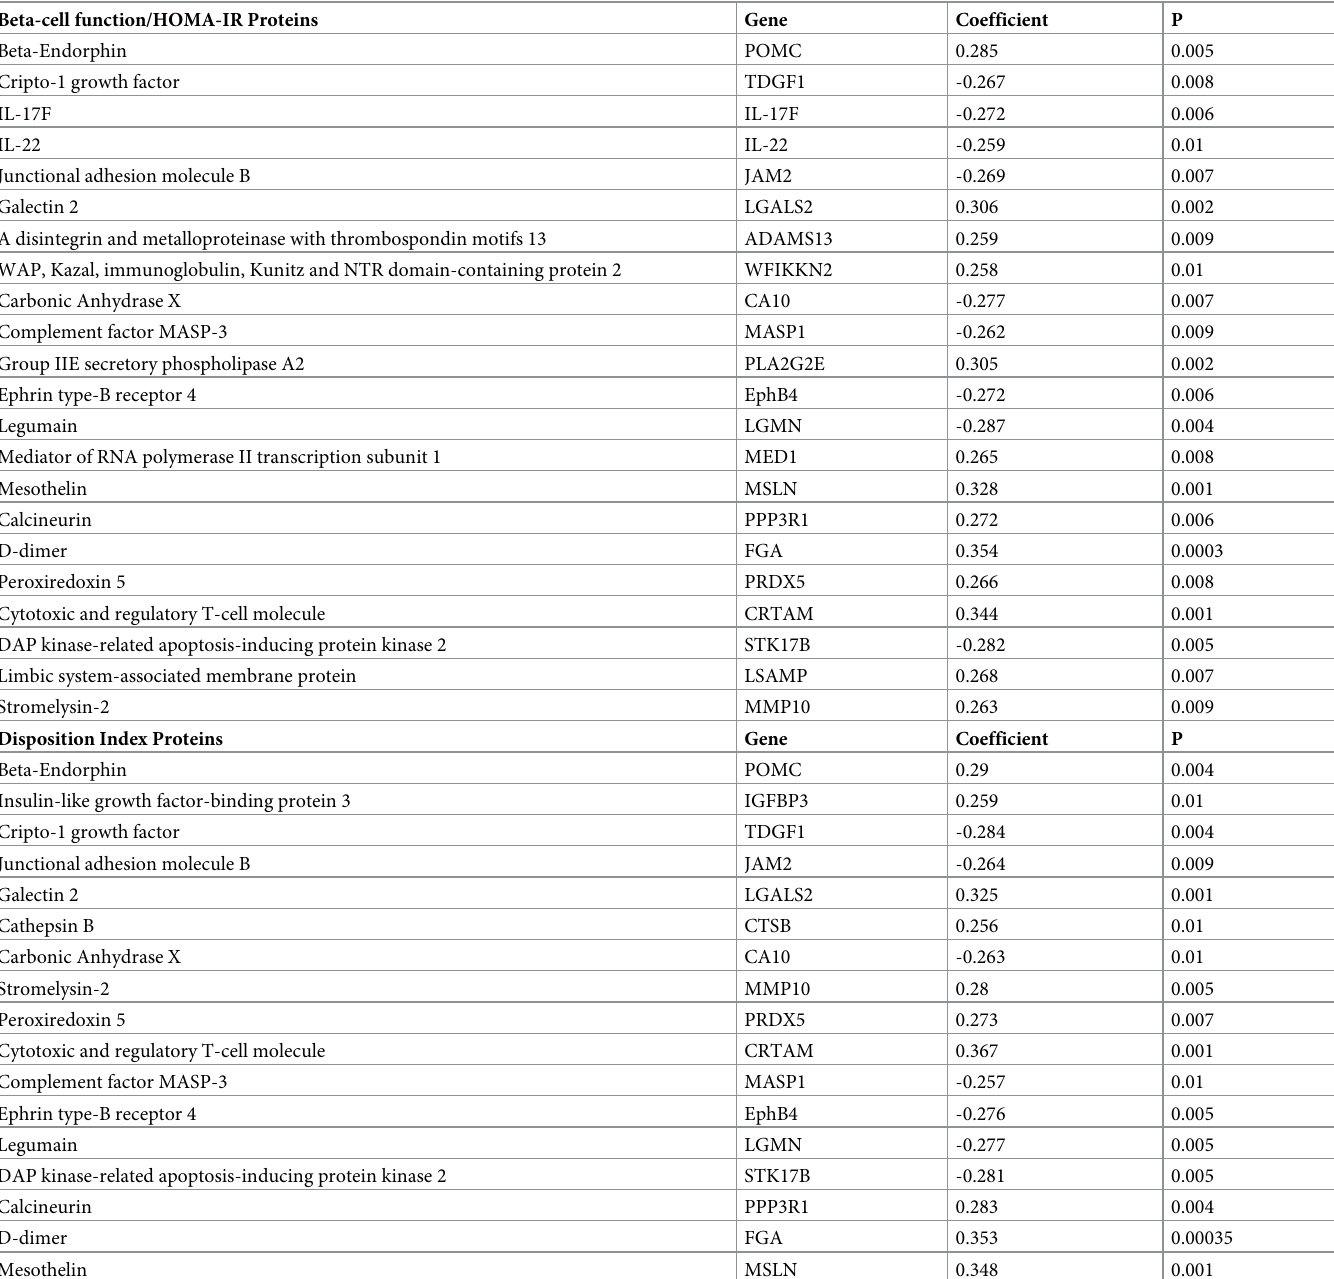
Table 2. Pearson’s correlation of proteins with beta-cell function/HOMA-IR and the disposition index. Beta-cell function/HOMA-IR